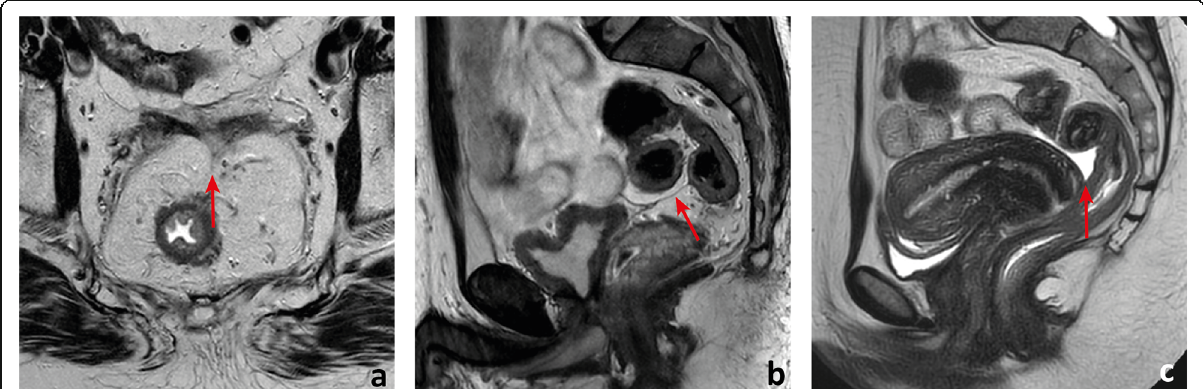
Fig. 6 The peritoneal reflection, when visible, may present with a seagull or V-shaped appearance on the (oblique) axial plane (arrow in a ). The sagittal plane is depicted as a hypointense line extending from the rectal wall to the roof of the mesorectal fascia (arrow in b ). It is more easily identified whenever there is a small amount of peritoneal effusion, which will accumulate immediately above it (arrow in c )